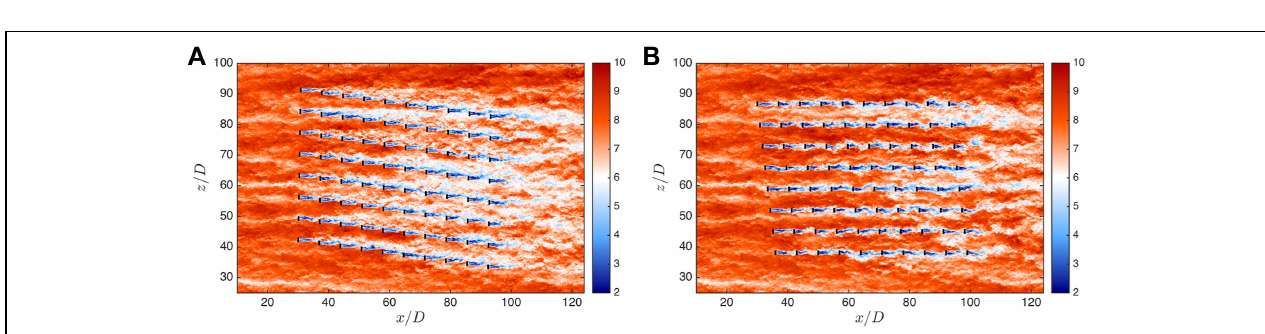
FIGURE 2 | Time- and horizontally-averaged streamwise velocity profile (presented in both (A) and (B) but in different ways) and turbulence statistics (C) for the ABL simulation. In (A,B) , the ABL velocity profile (solid line with circles) is compared to the logarithmic law (solid line). In (C) , the TI is shown for statistics computed based on the streamwise component (solid line with circles) and based on the three velocity components (solid line). The horizontal dashed line represents the hub height and H is the height of the domain.